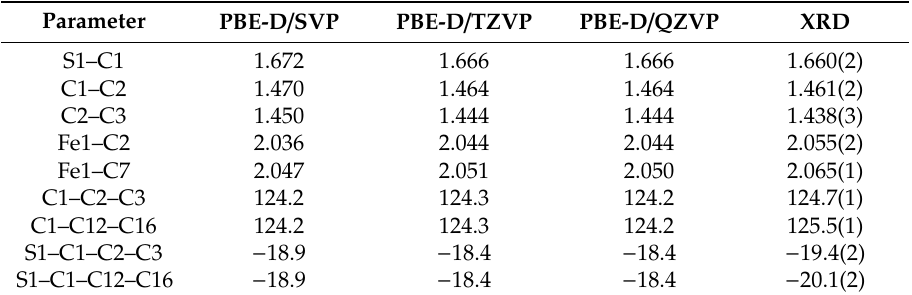
Table 2. Selected geometrical parameters for the optimized isolated Fc 2 CS molecule and for the molecule extracted from the XRD structure of Fc 2 CS crystal. The numbering of atoms corresponds to that shown in Figure 1. Bond lengths are given in Å and angles are in ◦